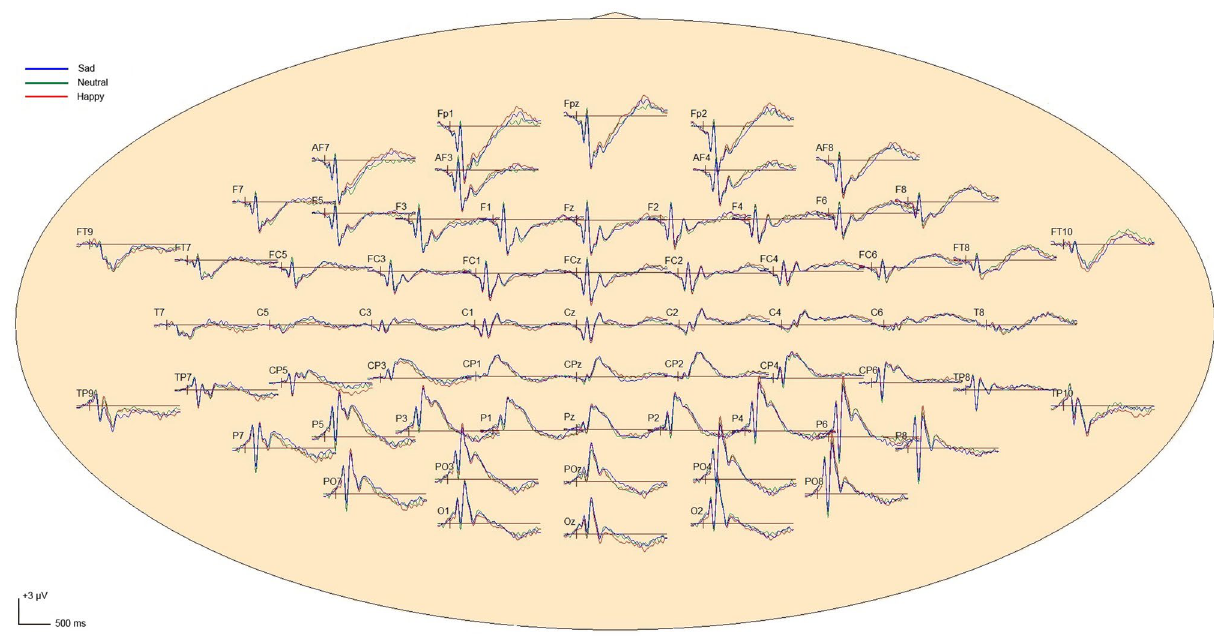
Figure 3. Top view of 64-channel ERP waveforms in the sad, happy and neutral conditions. Blue curves present grand average ERP waveforms across all participants in the sad condition; green curves present grand average ERP waveforms across all participants in the neutral condition; red curves present those in the happy